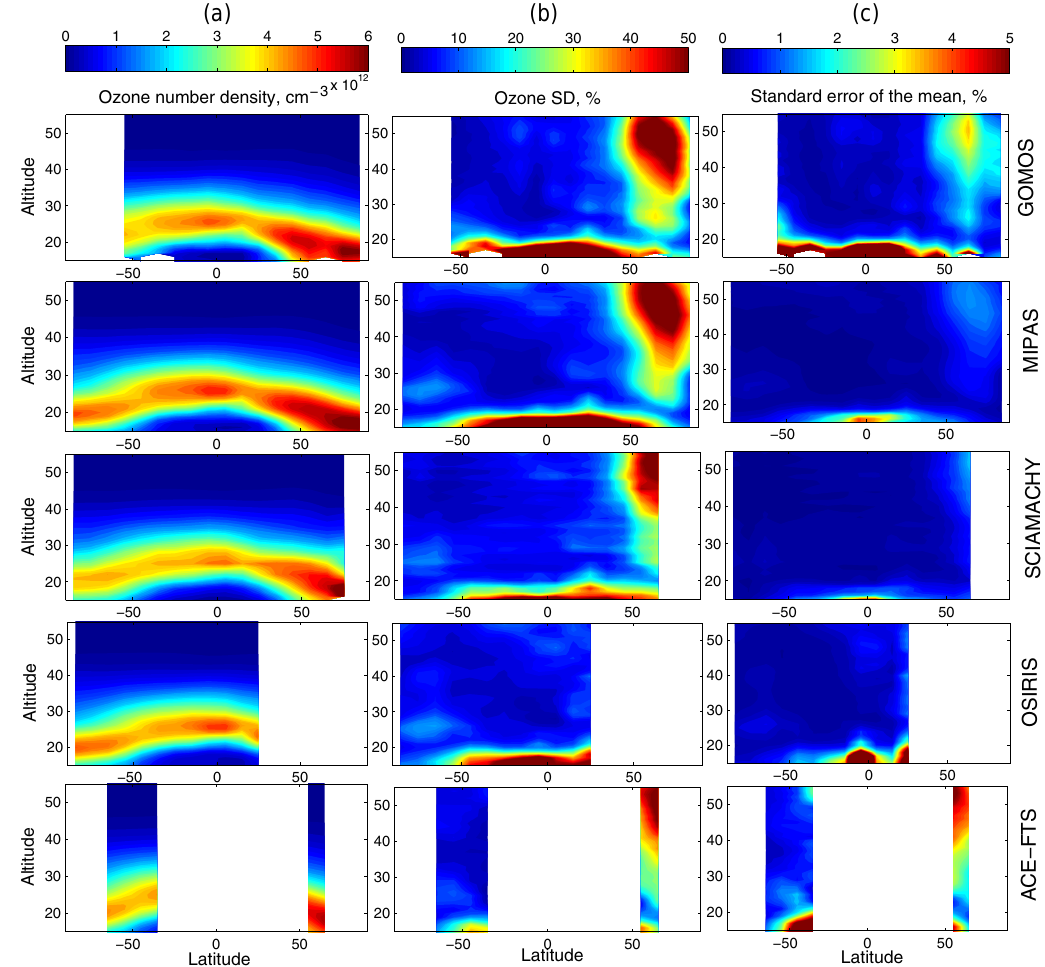
Figure 2. (a) Monthly zonal mean ozone profiles for January 2008 for Ozone_cci instruments, (b) sample variability (%), (c) standard error of the mean calculated using Eq.